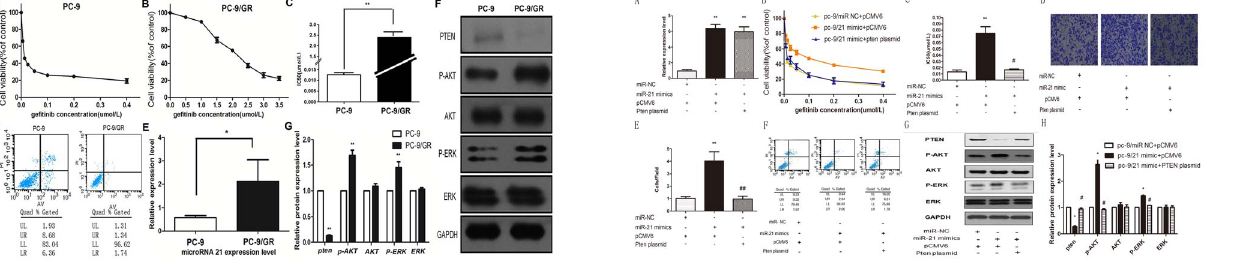
Figure 3. pc-9/GR cells show gefitinib resistance properties, up- regulation of miR-21 and down-regulation of PTEN compared with pc-9 cells. (A, B) pc-9 and pc-9/GR cells were treated with gefitinib for 72 h in 0.1% serum-containing RPMI. Cell growth was measured by CCK-8 assay in triplicate. Cell growth at 72 h is plotted against gefitinib concentration. (C) gefitinib IC 50 in pc-9 and pc-9/GR cells with triplicate assays performed. **indicates p , 0.01. (D) Apoptosis rates of pc-9/GR and pc-9 cells induced by gefitinib were evaluated by flow cytometry. pc-9/GR and pc-9 cells were treated with 1 m mol/L gefitinib for 72 hours before apoptosis evaluation. (E) Relative expression levels of miR-21 in pc-9 and pc-9/GR cells assessed by stem-loop qRT-PCR, and normalized to U6 levels. Triplicate assays were performed for each RNA sample. Significant differences are indicated by *(P , 0.05). (F) Pten, p-AKT, AKT, p-ERK, ERK proteins in pc-9 and pc-9/GR cells analyzed by Western blot. (G) Quantitation of western blot analysis showed that Pten protein expression was reduced in PC-9/GR cell compared with PC-9 cells **P , 0.01; p-AKT and p-ERK proteins expression were up-regulated in PC-9 GR cells compared with PC-9 cells **P , 0.01; there were no significant differences of total AKT and total ERK proteins between PC-9 and PC-9/GR cells. the influence of miR-21 on invasive ability. We found that miR-21 transfected pc-9 cells were more invasive than the NC group and over-expression Pten could rescue this invasive ability **p , 0.01 (Fig. 4D, 4E). In order to detect the impact of miR-21 on gefitinib induced apoptosis, the cells described above were treated with 1 m mol/L gefitinib for 72 hours. Using flow cytometry, we found that in pc-9 cells, a marked decrease in apoptosis was observed in miR-21 mimic transfected cells compared with NC transfected cells and miR-21 mimic and Pten plasmid co-transfected cells after gefitinib treatment(Fig. 4F). To better understand the molecular mechanisms involved in miR-21 induced gefitinib resistance in pc- 9 cells, western-blot assays were used to assess the expression of related proteins. In pc-9 cells, elevated expression of miR-21 resulted in repression of Pten expression and activation of p-AKT and p-ERK in comparison with the NC group, but did not change total protein expression of AKT and EKR. Over-expression of Pten expression could rescue up-regulation of miR-21 induced activation of p-AKT and p-ERK. (Fig. 4G, 4H).